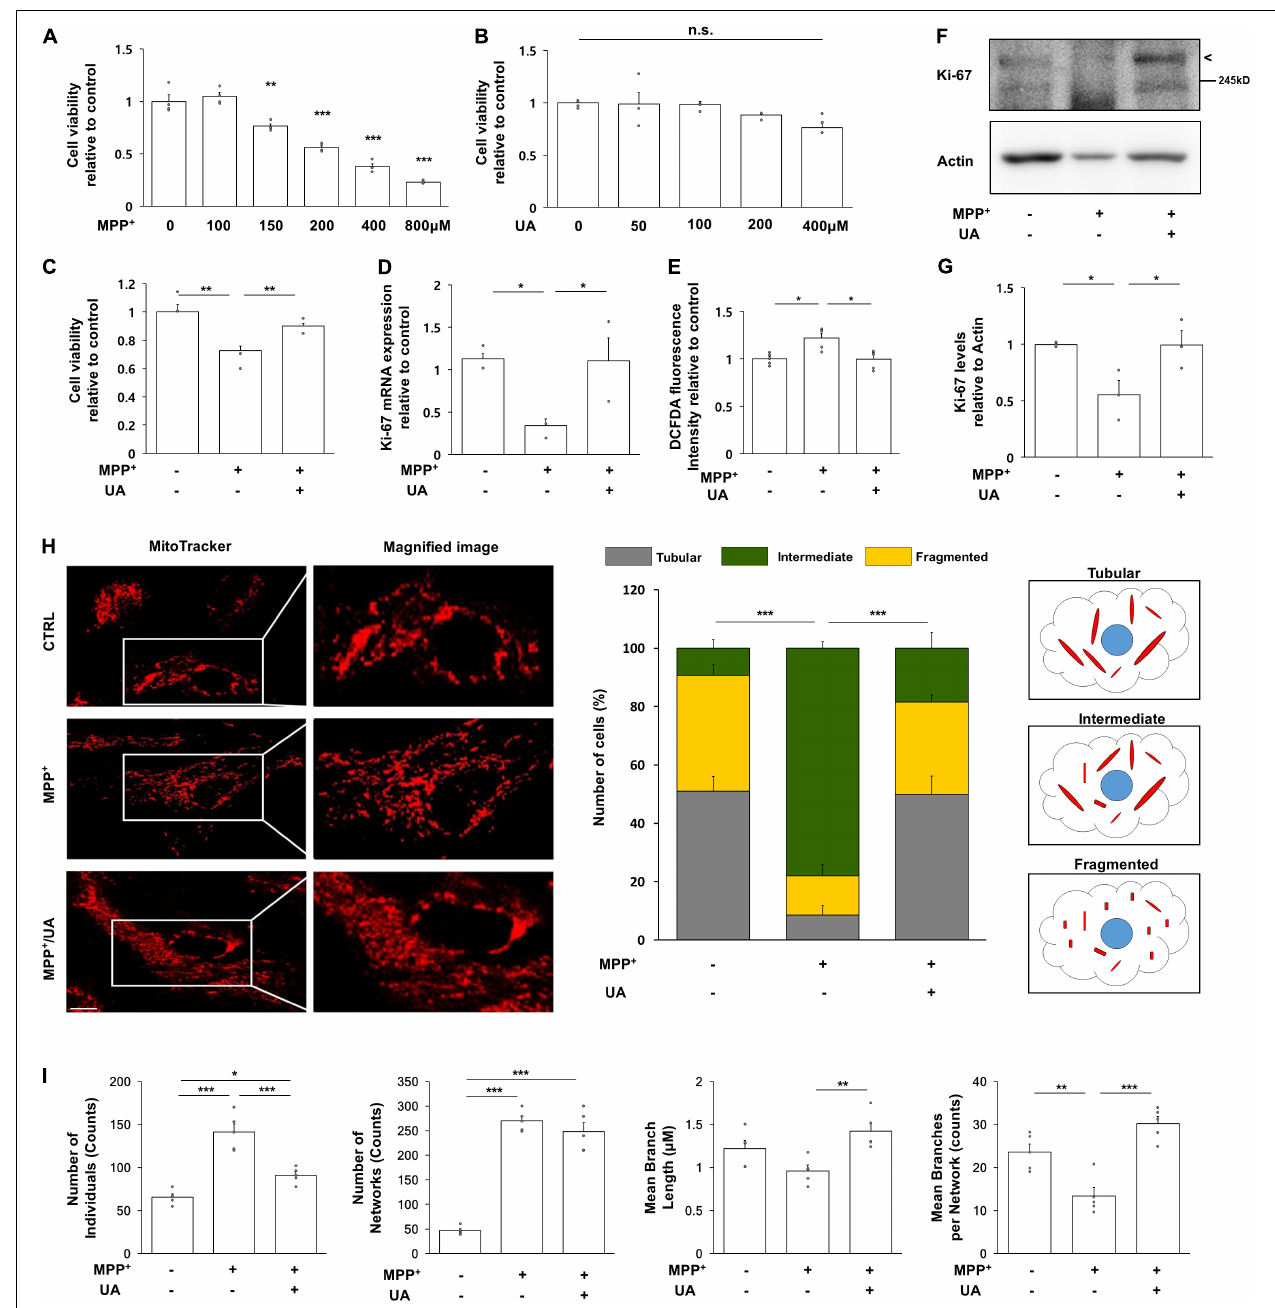
FIGURE 2 | UA treatment exerted neuroprotective effect and promoted proliferation in primary cultured NPCs. (A) MTS analysis in MPP + -treated NPCs with a concentration of 100, 150, 200, 400, and 800 µ M. 150 µ M of MPP + treatment induced about 56% of viability on NPCs ( n = 4 per group). (B) MTS analysis in UA-treated NPCs with a concentration of 50, 100, 200, and 400 µ M. UA treatment did not induce statistically significant cell death up to 400 µ M ( n = 4 per group). (C) MTS analysis in MPP + treated or MPP + with UA-treated NPCs at a 150 µ M concentration of UA for 24 h and MPP + for 72 h with UA co-treatment. UA exerted a neuroprotective effect on NPCs by restoring cell viability up to 90% compared to control ( n = 4 per group). (D) Quantitative RT-PCR for proliferation marker, Ki-67. The expression level of Ki-67 was reduced to 41.6%; however, UA restored it to 92.2% compared to control. (E) Intracellular ROS as measured by DCFDA assay after MPP + and UA treatment. MPP + -induced ROS was scavenged by UA pre-treatment. (F) Western blot for proliferation marker, Ki67 in MPP + and UA-treated NPCs. (G) Quantification graph of Ki-67 western blot analysis. (H) Immunofluorescent labeling for mitotracker. MPP + -treated NPCs showed fragmented mitochondrial morphology, whereas UA treatment restored them similar to those of controls. (I) Mitochondrial network analysis using MiNA. UA treated NPCs showed lower number of individuals (puncta), longer branch length, and lower branch number per network compared to the MPP + treatment group. Each five images per group were analyzed. Scale bar: 10 µ m. Differences among the conditions were evaluated by ANOVA with a Bonferroni correction for multiple comparison. The data are presented as the mean ± SE. * p < 0.05, ** p < 0.01, and *** p < 0.001.